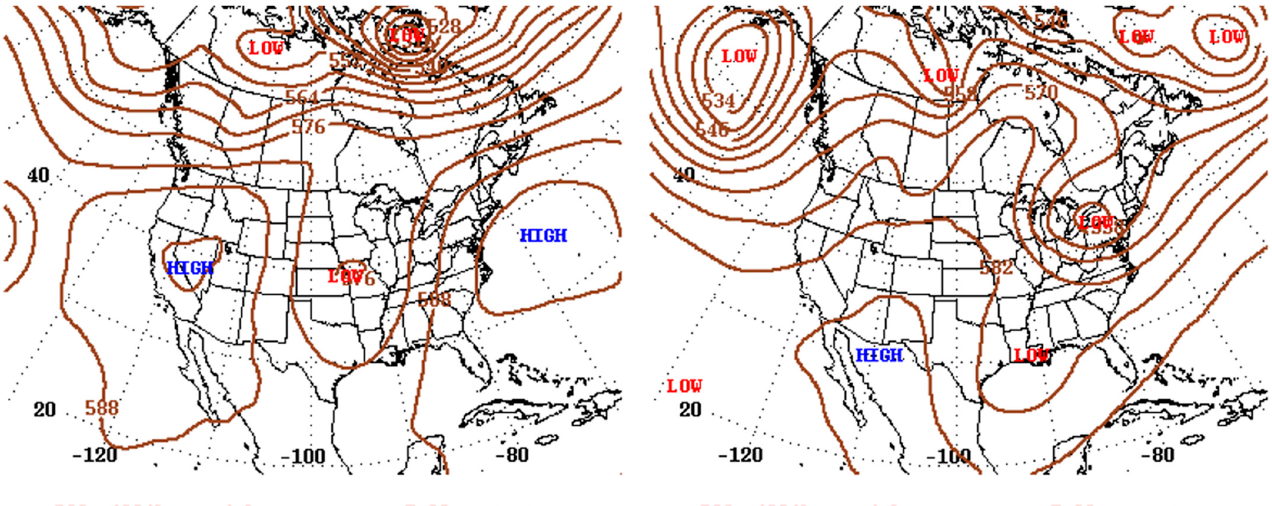
Figure 5. 500 hPa height contour at 5:00 am MST on 03 July 2013 ( left ) and 06 June 2017 ( right ), both high ozone episodes. The presence of a high-pressure ridge around and over the EPJA can be seen during the ozone exceedance event.